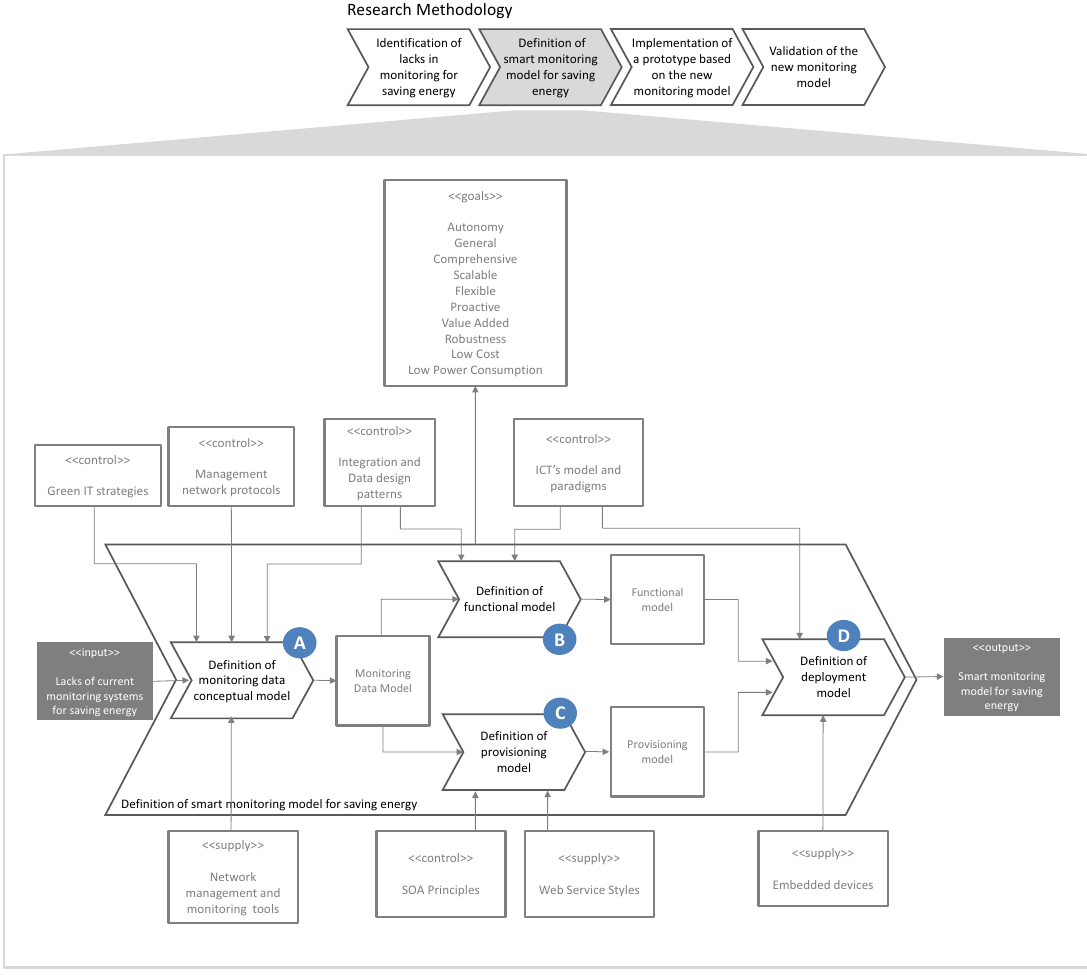
Figure 1. Modeling (Eriksson-Penker notation) of definition of smart monitoring model for saving energy.